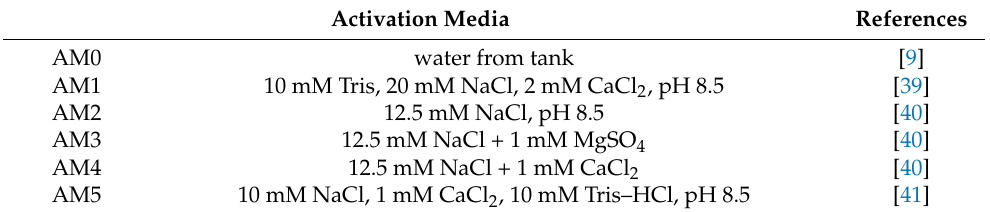
Table 1. Activation media (AM) used to activate fresh sturgeon